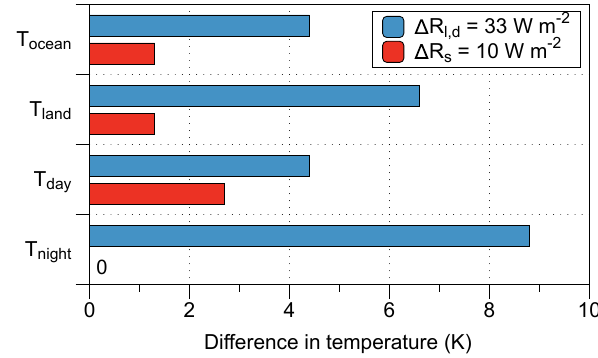
Figure 5. Difference in ocean and land temperatures as well as day- time and nighttime temperatures resulting from an enhanced green- house effect ( (cid:49)R l , d = + 33Wm − 2 ) and from enhanced absorption of solar radiation at the surface ( (cid:49)R s = + 10Wm − 2 ), using the val- ues from Table